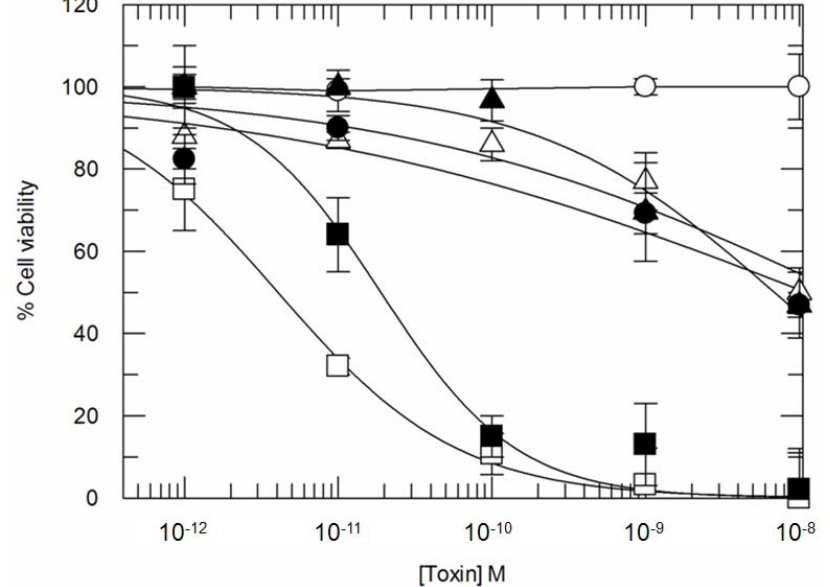
compared to KDEL ■ ○ ● ricin + BFA, CD7-SAP,